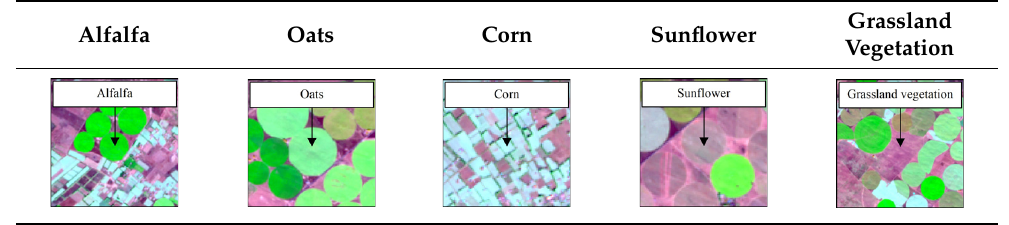
Table 5. Image features of different vegetation types at the pre-wintering stage (false color synthesis).